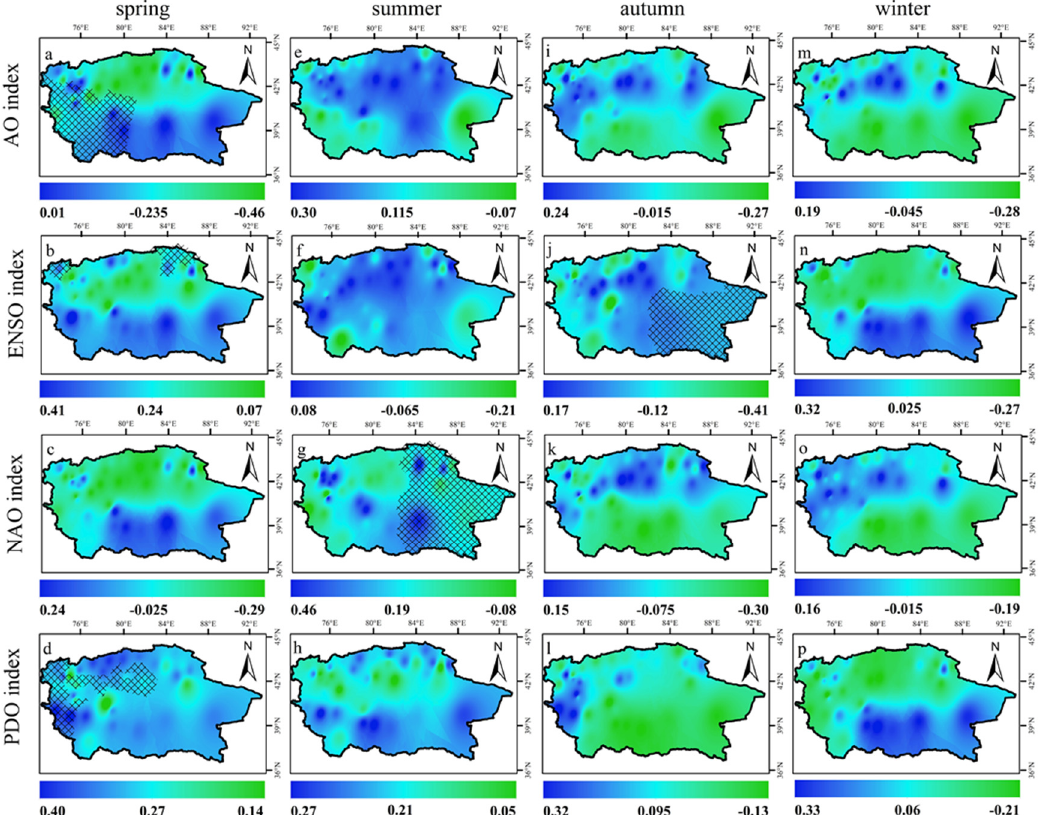
Figure 6. Spatial distribution of correlation between annual precipitation and atmospheric circulation in the Tarim Basin. Each column in the figure corresponds to a season, and each row corresponds to an atmospheric circulation index (The black grid indicate that the trends are statistically significant at the 0.05